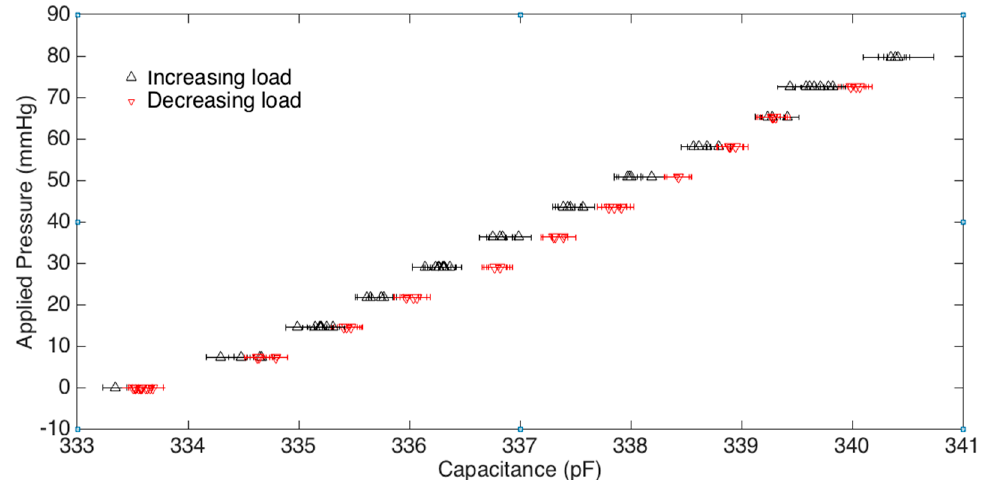
Figure 8. Sensor capacitance at various applied pressures–mass test results.